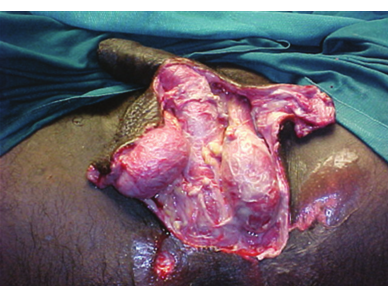
Figure 2: FG after debridement.